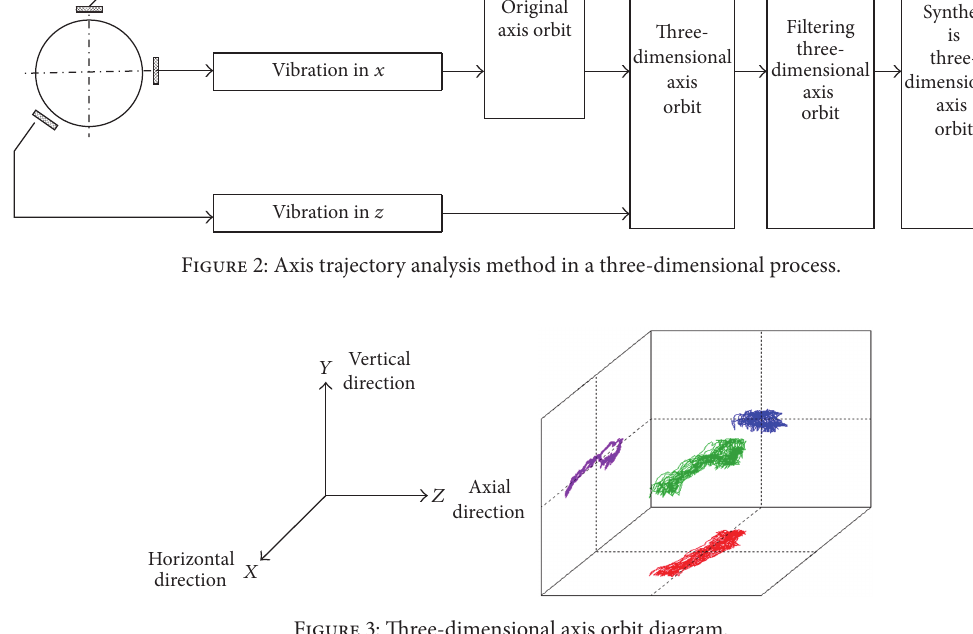
Figure 3: Three-dimensional axis orbit